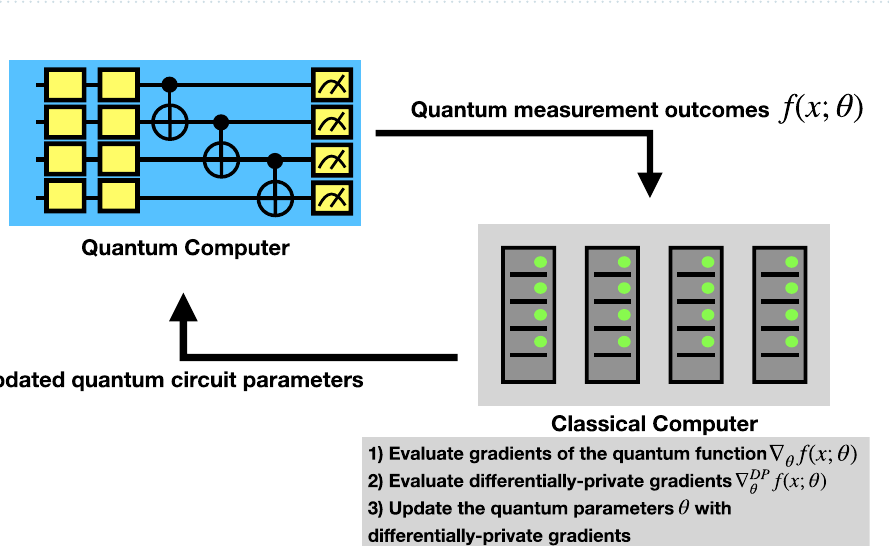
Figure 5. Differential Privacy in Quantum Machine Learning. In the proposed framework, the outputs from the quantum circuit are processed on a classical computer. The gradients of the quantum function ∇ θ f ( x ; θ) and the differentially private gradients ∇ DP θ f ( x ; θ) are calculated. The quantum circuit parameters are updated according to the differentially private gradients and fed back to the quantum